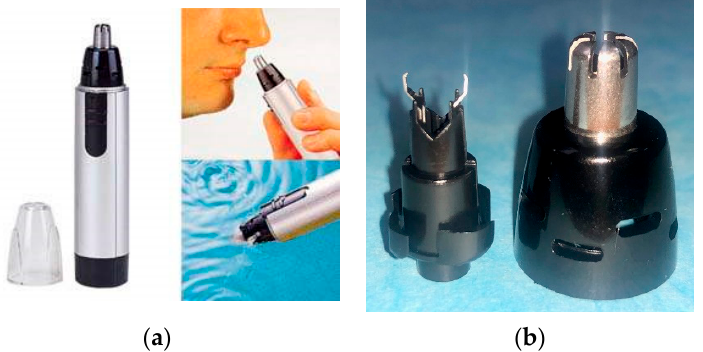
Figure 6. Self-washable nose hair trimmer. ( a ) Illustration of self-wash function; ( b ) Inner blade supporter with propeller.